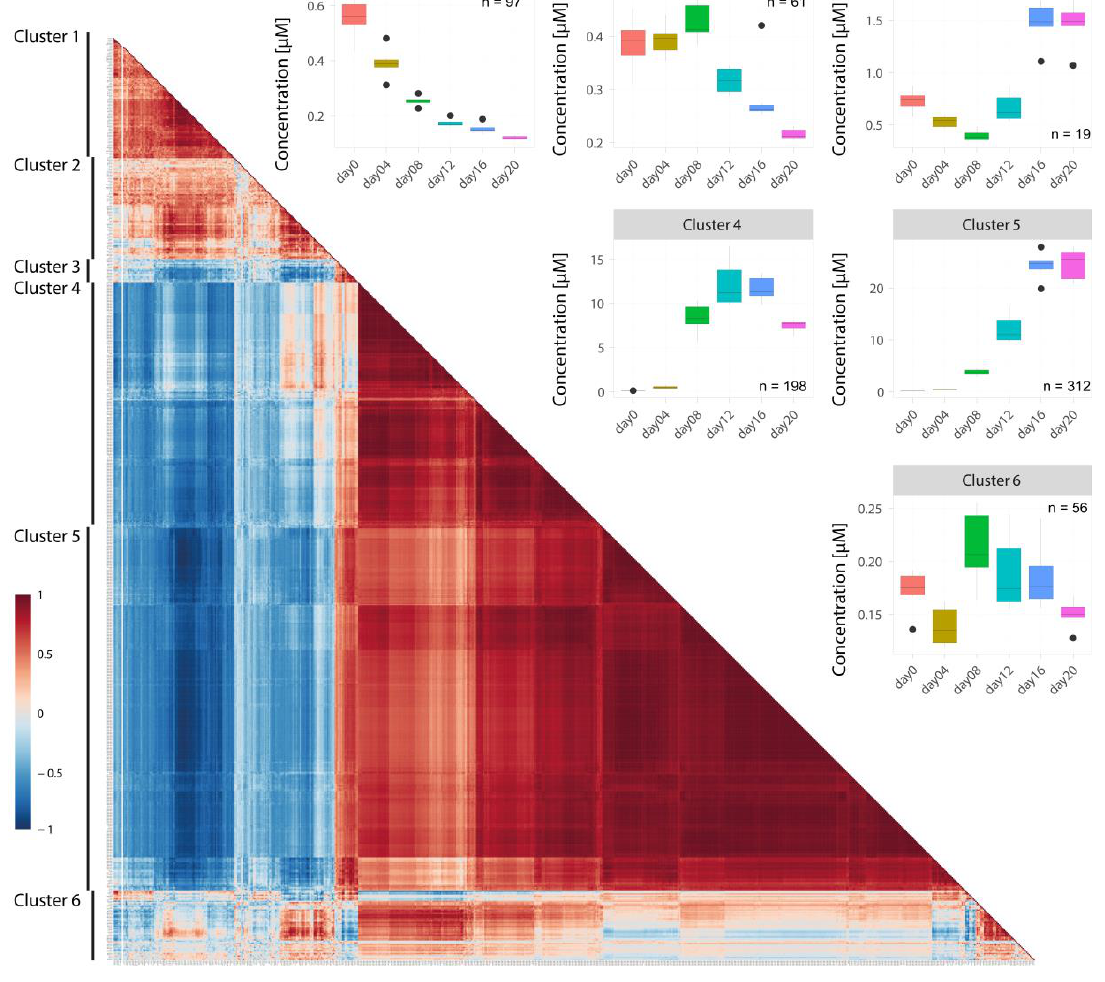
Figure 5. Spearman’s rank correlation analysis of lipid concentration trajectories during adipogenesis showed strong clustering and correlation of the lipid species. Panel A illustrates the matrix of the analysis where each square indicates the Spearman’s rank correlation coefficient. Positive correlations between the variables are shown in red, while negative correlations are shown in blue. Correlation matrix enables the assignment of six lipid clusters. Species were clustered using Ward’s clustering algorithm. Panel B shows the changes of the average lipid concentration in the different clusters with time.